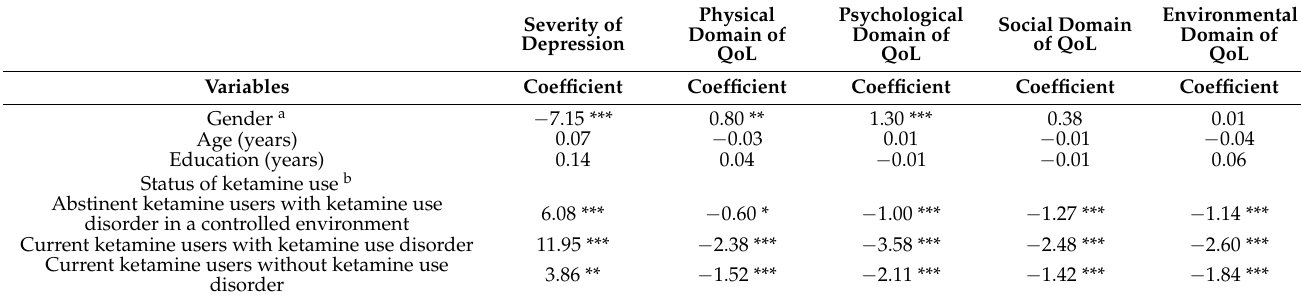
Table 3. Associations of gender and status of ketamine use with the severity of depression and quality of life (QoL).